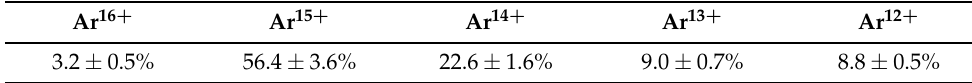
Table 1. The estimated charge state composition of the Ar EBIT